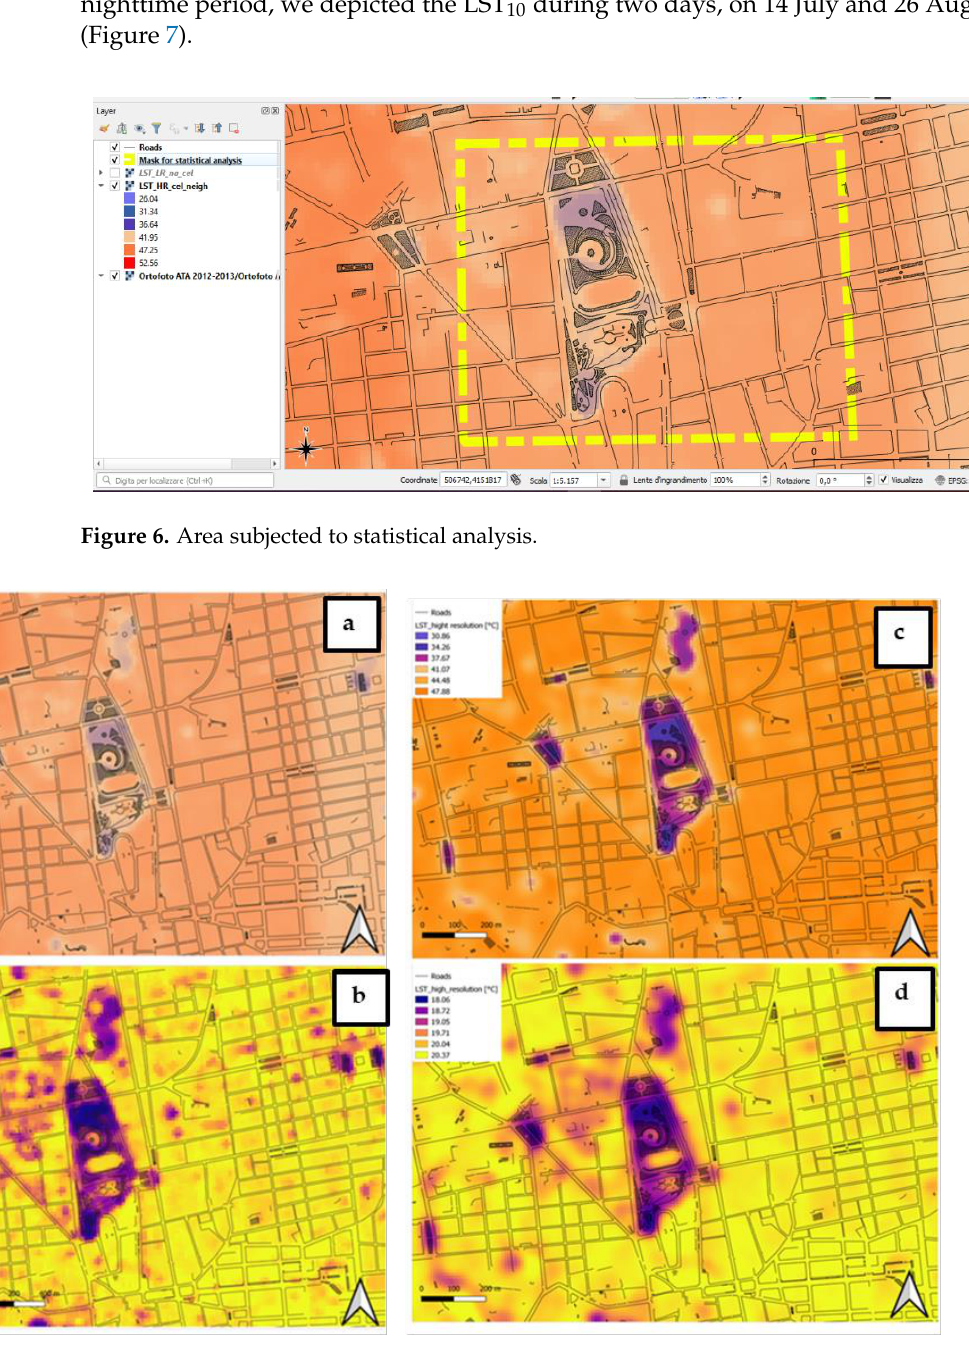
Figure 8. Daytime ( a ) and nighttime ( b ) LST differences on 26 August 2017. Looking at the atmospheric temperatures measured by the WS1 on these days, the green areas have temperatures 2 – 3 °C lower than the surrounding areas. Thus, it is possi- ble to assert that the green areas in addition to the evapotranspiration effect, further con- tribute to cooling down the environment through sensible heat fluxes. On the contrary, the built-up areas have LST temperatures 15 – 17 °C higher than the atmospheric tempera- tures. This outcome indicates that the very hot pedestrian surface contributes to the in- b b